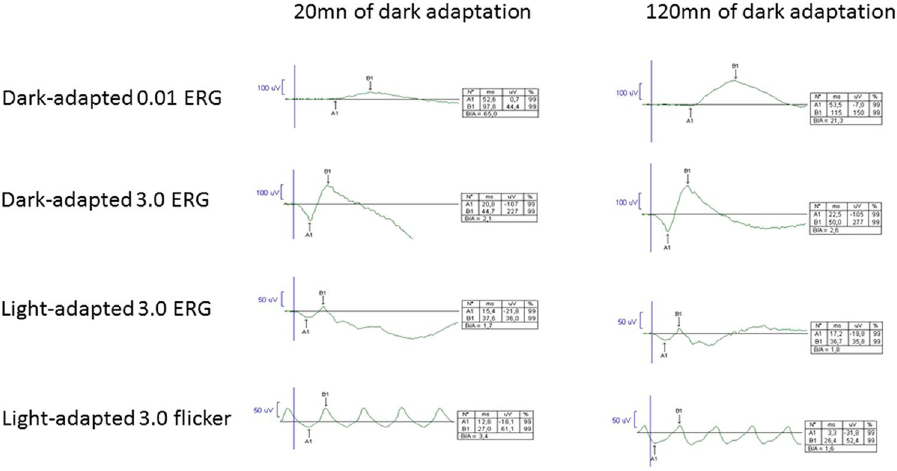
Figure 5. Full-field electroretinogram in EMAP patient. Dark-adapted 0.01 ERG responses are reduced after a 20 minute-dark adaptation time (ISCEV protocol), but dramatically recover after a 120 minute prolonged dark adaptation. The rod-impairment could be induced by the pseudodrusen i.e. diffuse subretinal deposits located between the retinal pigment epithelium and the inner and outer segments of the photoreceptors. Severe decrease of Light-adapted 3.0 ERG and flicker ERG responses as noted in EMAP patients, and not in AMD, suggests that cone degeneration is part of the EMAP